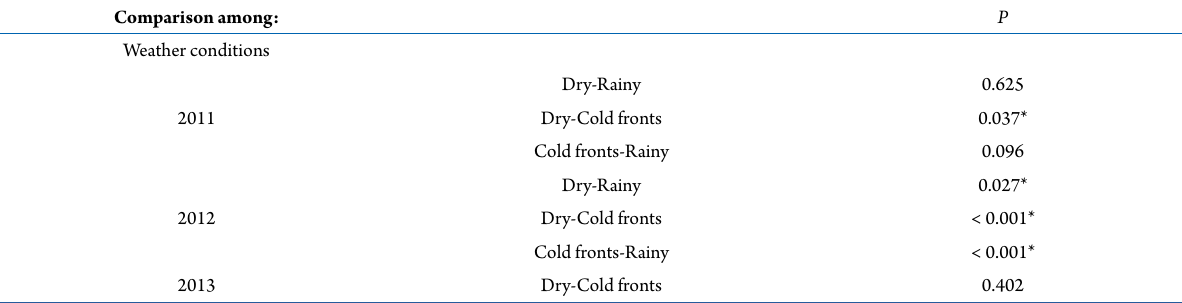
Table 8. Comparison of the values of diversity Shannon with Hutcheson (1970) test. * significant difference. Comparison